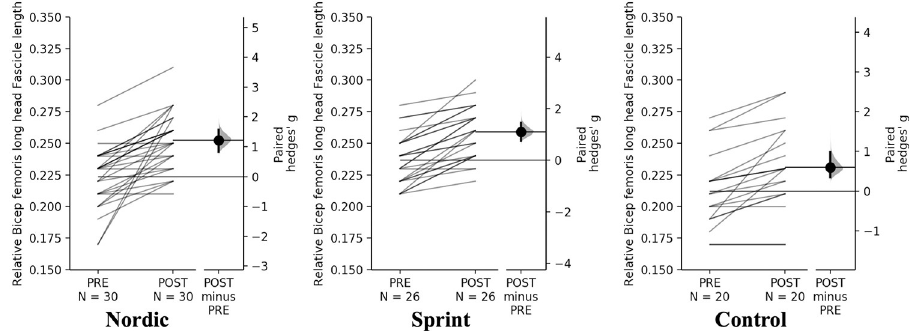
Fig 3. Gardner-Altman estimation plots identifying Pre- and Post-intervention individual changes for relative bicep femoris fascicle length and Hedge’s g effect size with the 95% CI indicated by the ends of the vertical error bar.